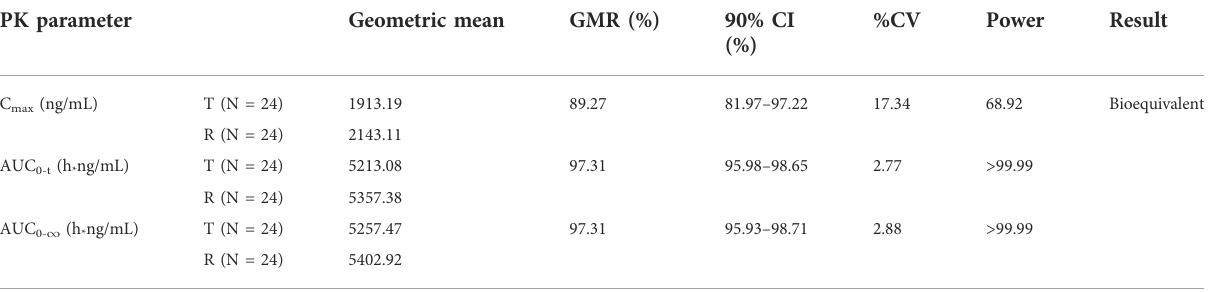
T, test drug was Cefaclor granule; R, reference drug was Cefaclor suspension; PK, Pharmacokinetic; N, number of subjects; GMR, geometric mean ratios; CI, con fi dence Interval; CV%, within-subjectcoef fi cientofvariation;AUC 0-t ,theAUCoftheanalyteintheplasmaoverthetimeintervalfromtimezerotothelastmeasurableconcentration;AUC 0- ∞ ,theareaunderthe curve from 0 to in fi nity; C max , the maximum observed drug concentration in the plasma.